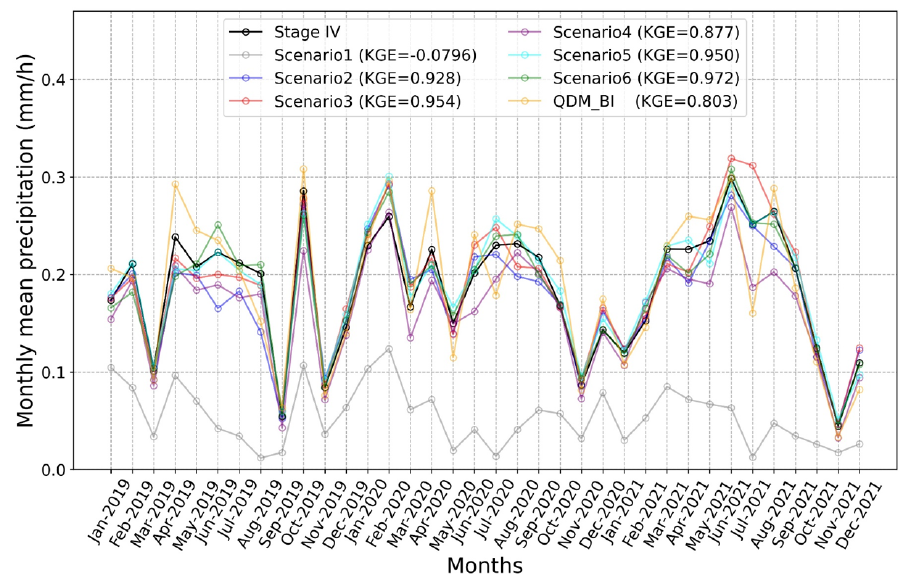
Figure 6. Monthly mean of hourly precipitation time series during the testing period (2019–2021) from Stage IV, QDM_BI, and 6 DL experimental runs (Scenario1–Scenario6). Table 4. Performance of extreme indices including hourly P at the 99th percentile and annual maximum wet spell in hours. KGE represents the modified Kling-Gupta efficiency (KGE) and it includes three components (correlation component r , bias component β and variability component γ ). The correlation component r is represented by the correlation coefficient, the bias component β is represented by the ratio of estimated and observed means, and the variability component γ is represented by the estimated and observed coefficients of variation. Extreme indices Scenarios ∗ KGE r β